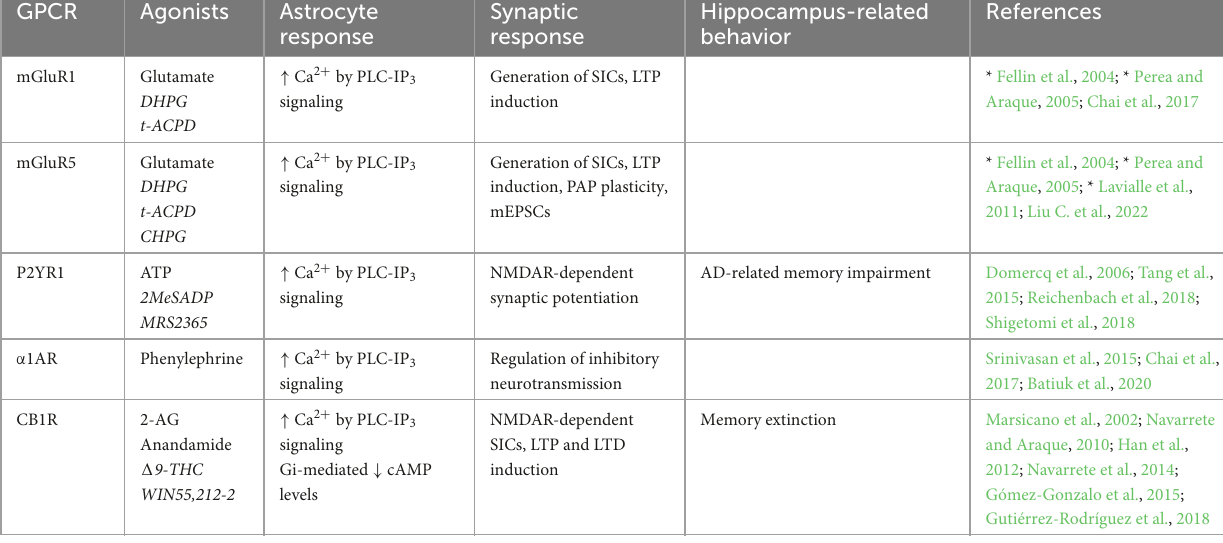
TABLE 1 Endogenous Gq-GPCRs in adult mouse hippocampus: Synaptic and behavioral effects.